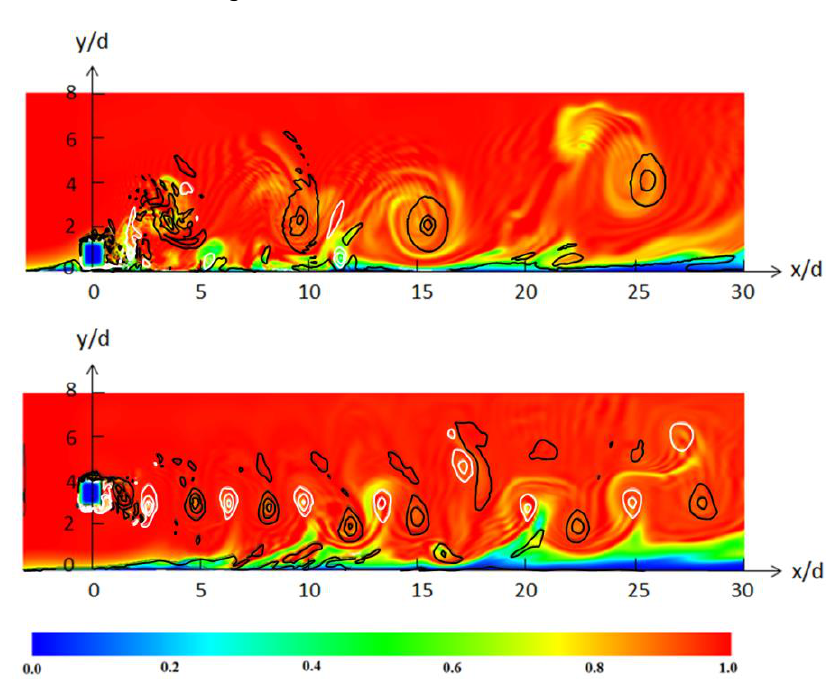
Fig. 8 Instantaneous temperature fields with the iso-vorticity line (black: negative/clockwise; white: positive/counter-clockwise). Upper image: 25.0/  dC ; lower image: 0.3/  dC